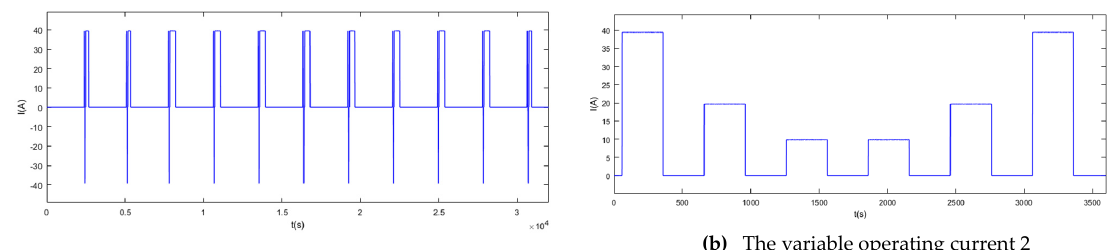
Figure 8. The internal structure of Thevenin model. Figure 9. The variable operating current. Figure 9. The variable operating